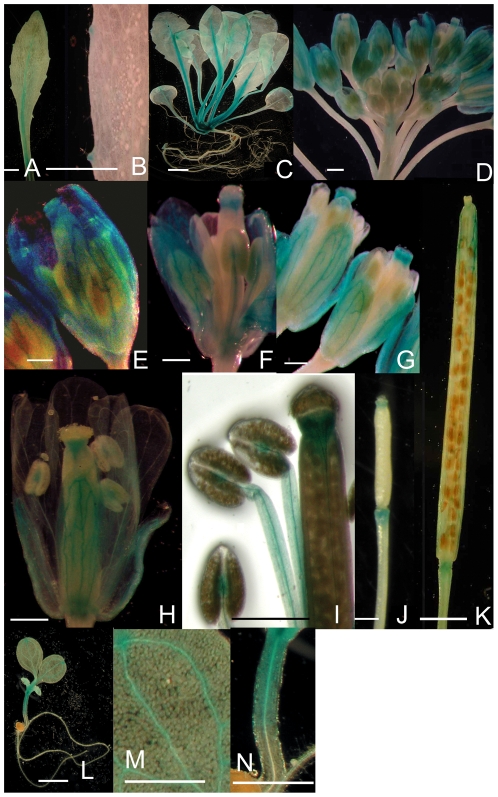
Histochemical localization of AtSOFL1 and AtSOFL2 in Arabidopsis.Transgenic plants expressing the AtSOFL1:AtSOFL1-GUS (A–F, H–N) or AtSOFL2:AtSOFL2-GUS (G) constructs were grown on half-strength Murashige and Skoog (MS) medium for one (L–N) or two weeks (C) or in soil for four (A–B), six (D–J) or eight weeks (K) in the greenhouse. A, Rosette leaf showing GUS staining in the midrib and hydathodes. B, Close-up of hydathodes. C, Whole plant. D, Inflorescence. E, Unopened flower showing staining in the sepal vasculature. F, Unopened flower that was opened to show staining in the vascular tissue of stamens and the pistil tip. G, Flowers for AtSOFL2:AtSOFL2-GUS transgenic plants. H, Fully-opened flower. I, Close-up of the pistil tip and stamens of a fully-opened flower. J, Young silique. K, Mature silique. L, One-week-old seedlings. M, Close-up of cotyledon. N, Close-up of hypocotyl. Scale bar  = 500 µm.